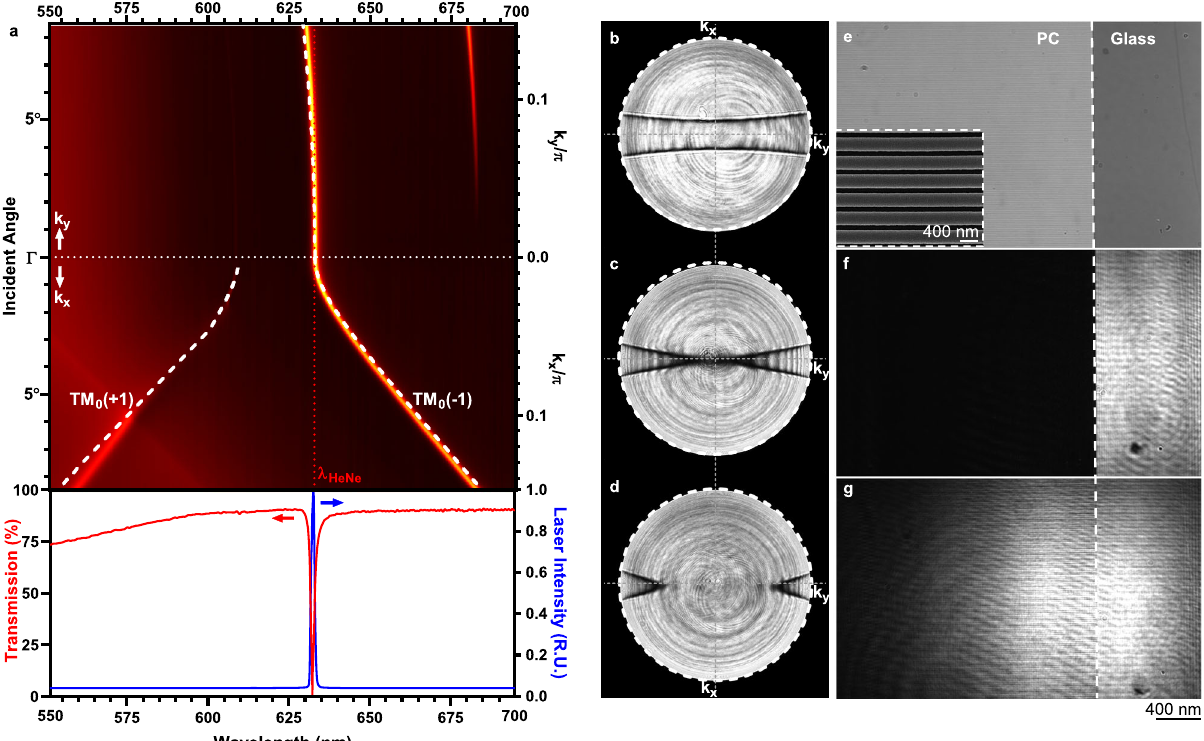
Fig. 2 Characterization of photonic guided resonance mode. a Dispersion diagram measured experimentally from the transmission spectrum, overlaid with numerically obtained photonic band structure (dashed white curves). The laser wavelength λ L = 633 nm is marked with a red dashed line, and the dotted horizontal line marks the normal incidence angle ( Γ point). Lower panel: transmission spectrum (red) at normal incidence along with the normalized laser emission spectrum (blue). b – d Experimentally recorded isofrequency contour by Fourier plane imaging, respectively from PCs with TiO 2 thickness of ( b ) 90 nm, ( c ) 97 nm, and ( d ) 105 nm. e Bright- fi eld re fl ection image of the border between the PC nanostructure and the glass substrate. Inset: scanning electron microscopy (SEM) image of the corrugated PC surface. f PRISM image of the resonating PC sample used in ( c ). The majority of the normally incident light is re fl ected, leaving the PC region appearing black in transmission mode. g PRISM image of the detuned PC used in ( d ), where the PC region is almost transparent due to resonance wavelength